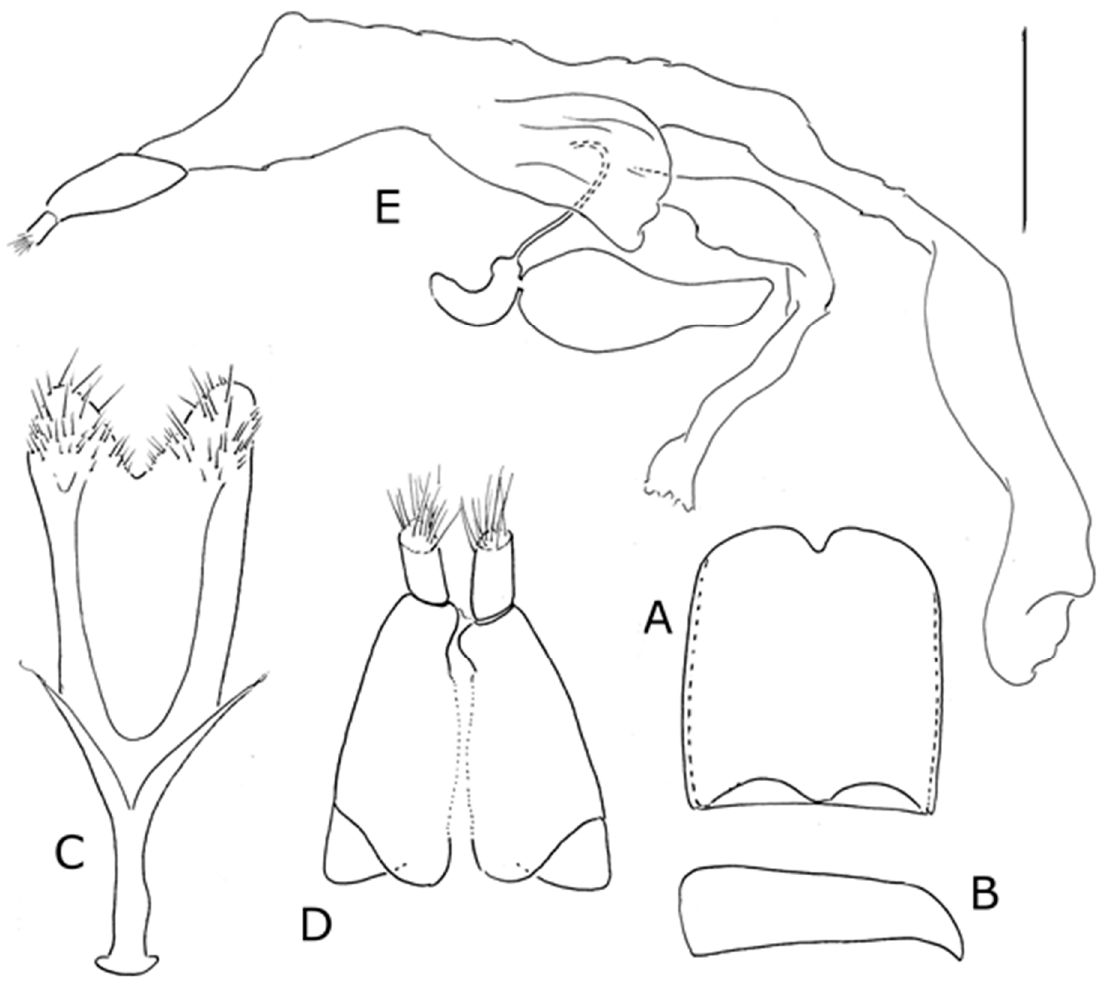
Figure 9. Sclerocardius africanus (Boheman), female terminalia: ( A ) tergite VIII, dorsal, ( B ) tergite VII, lateral, ( C ) spiculum ventrale, ventral, ( D ) gonocoxites, ventral, and ( E ) genitalia, lateral. Scale bar = 1 mm. Specimens